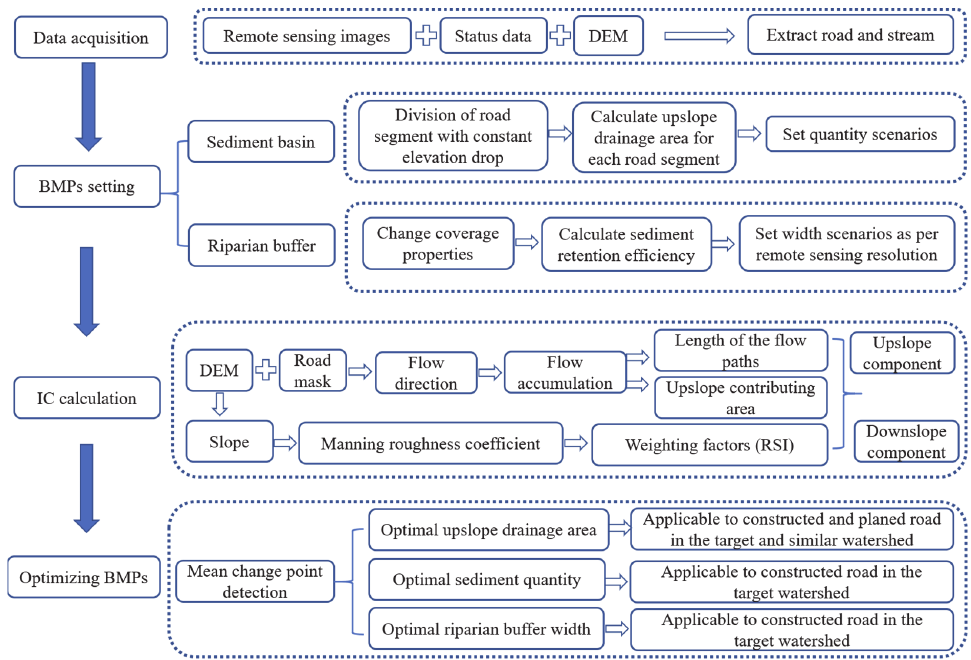
Figure 3. Flow diagram showing methodological framework.